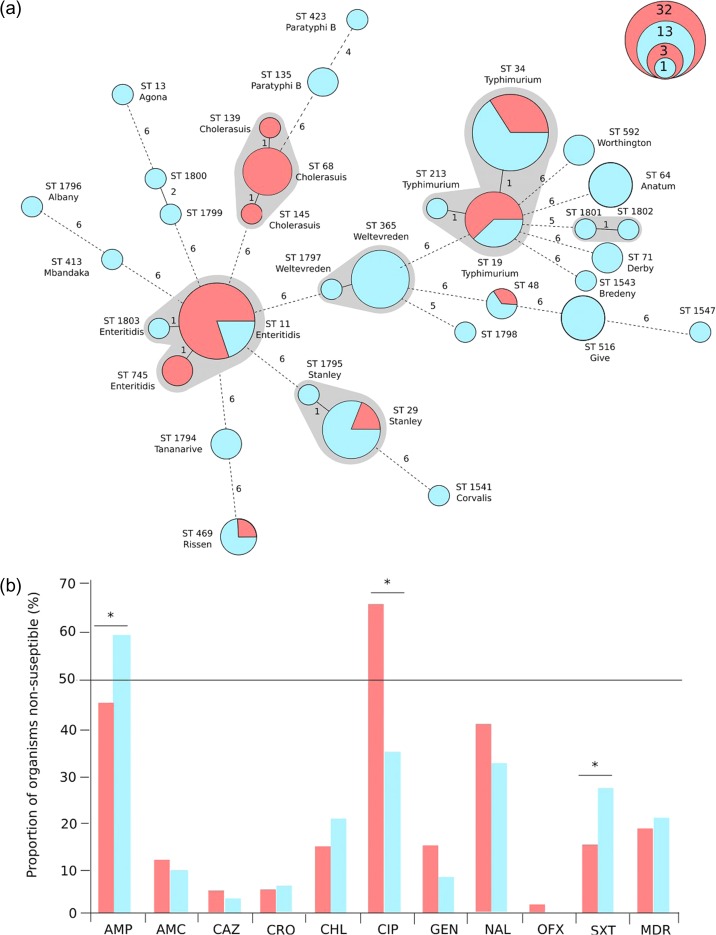
Identified Salmonella serovars causing invasive and non-invasive disease in Lao and their antimicrobial susceptibility profiles. (a) Minimum spanning tree of 168 Laotian NTS isolates created using seven-allele MLST profiling; the sources of the organisms are colour coded (red, blood; blue, faeces). The sequence type (ST) of each allele profile is shown along with the inferred serovar. Clonal complexes (S. enterica Typhimurium, S. enterica Enteritidis, S. enterica Choleraesuis, S. enterica Stanley and S. enterica Weltevreden) are highlighted. The size of each ST group corresponds with the number of isolates with the same ST profile (scale shown) and the branches are labelled by the number of variable alleles between STs. (b) Bar graph showing the proportion of organisms (red, blood; blue, faeces) exhibiting non-susceptibility (including intermediate resistance) against ampicillin (AMP), amoxicillin/clavulanate (AMC), ceftazidime (CAZ), ceftriaxone (CRO), chloramphenicol (CHL), ciprofloxacin (CIP), gentamicin (GEN), nalidixic acid (NAL), ofloxacin (OFX) and trimethoprim-sulfamethoxazole (SXT). Asterisks signify statistically significant differences in the proportion of organisms with non-susceptibility against the individual antimicrobial (p<0.05, Fisher’s exact test).